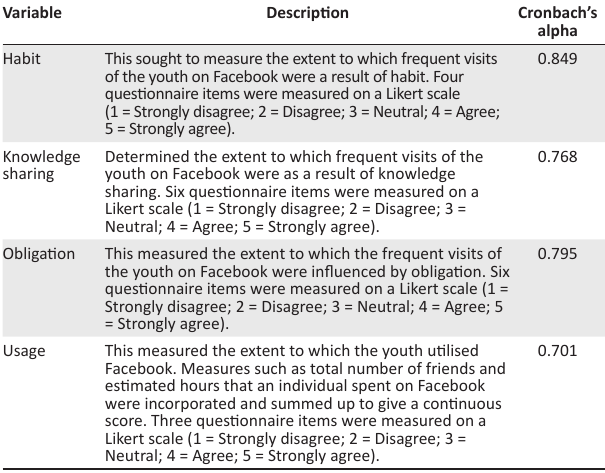
TABLE 1: Description of variables employed in the survey and their reliability